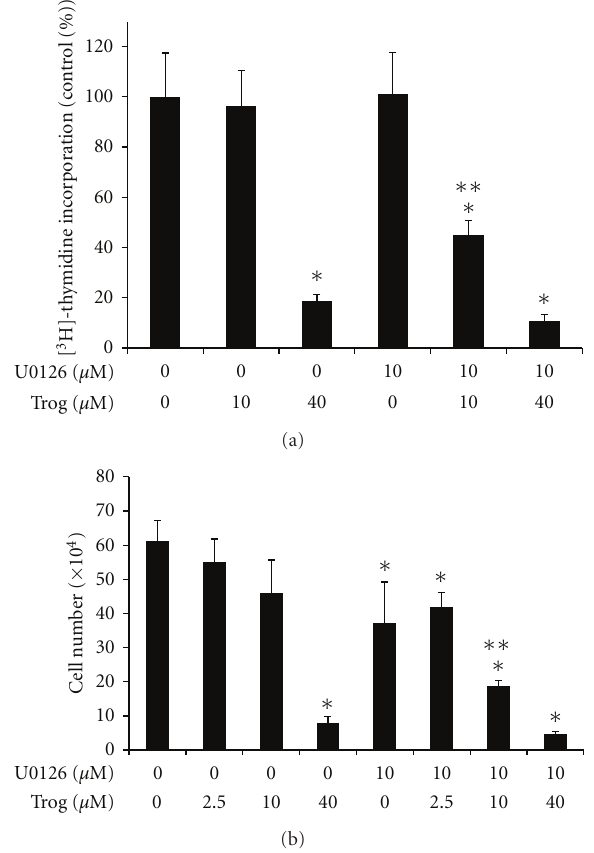
Figure 6: Combined e ff ect of U0126 and troglitazone on PC-3 cell proliferation. (a) PC-3 cells were first plated in 6-well plates at a density of 10,000 cells/well. The cells were then treated with DMSO vehicle or troglitazone (10–40 μ M) in the presence or absence of 10 μ M U0126. [ 3 H]-thymidine incorporation assays were then used to measure proliferation of treated cells. (b) PC-3 cells were plated in 6-well plates at a density of 10,000 cells/well and treated for six days with DMSO vehicle or troglitazone in the presence or absence of 10 μ M U0126. Following treatment, the cells were detached using trypsin-EDTA and counted using a Coulter Counter. For both panels, each bar represents the mean ± SD for three wells. ∗ P < 0 . 05 compared to DMSO control. ∗∗ P < 0 . 05 compared to U0126 alone and 10 μ M troglitazone